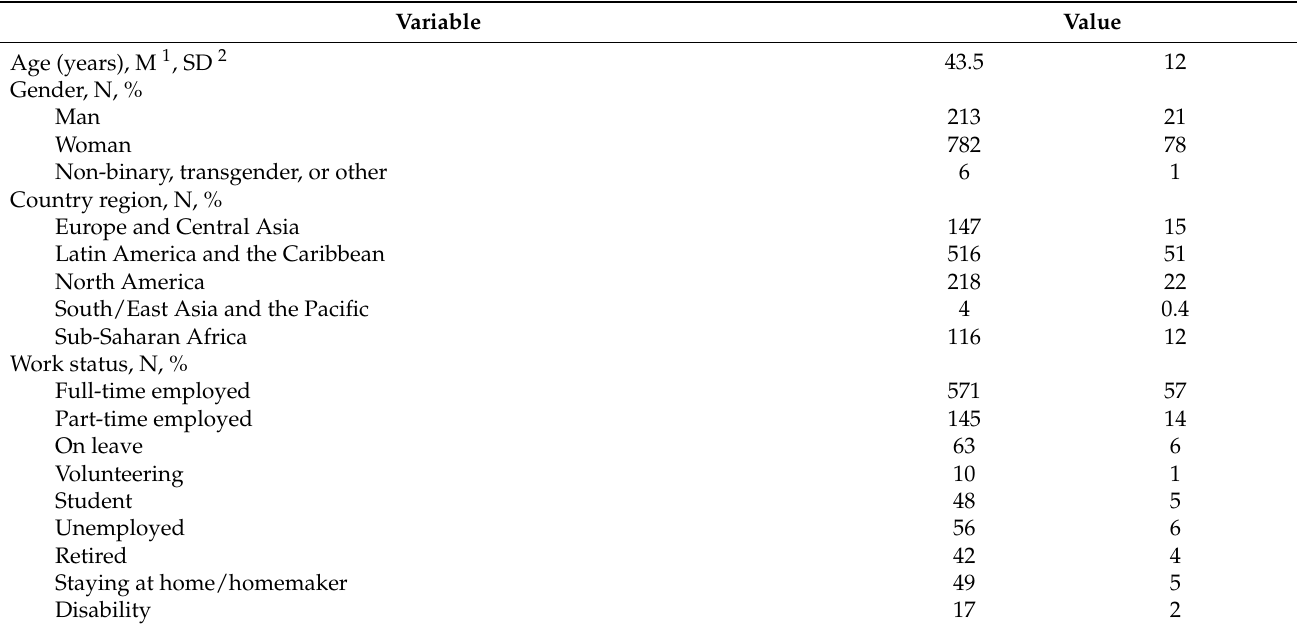
Table 1. Sociodemographic characteristics of the study cohort (N =